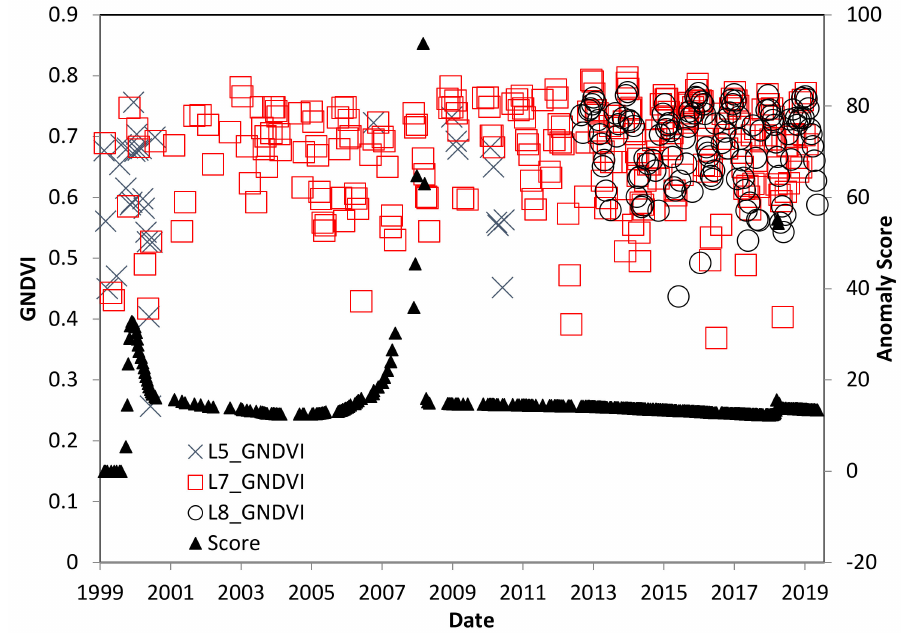
Figure 8. GNDVI time series for the El Salvador study site, showing variations caused by distinct rainy and dry seasons. R. indica was first observed at this site in 2015.